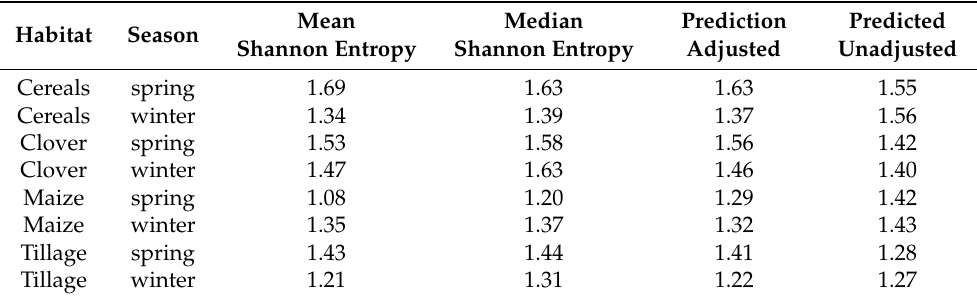
Table 5. Model predictions compared to Shannon entropy (mean and median) of the topsoil seed bank.